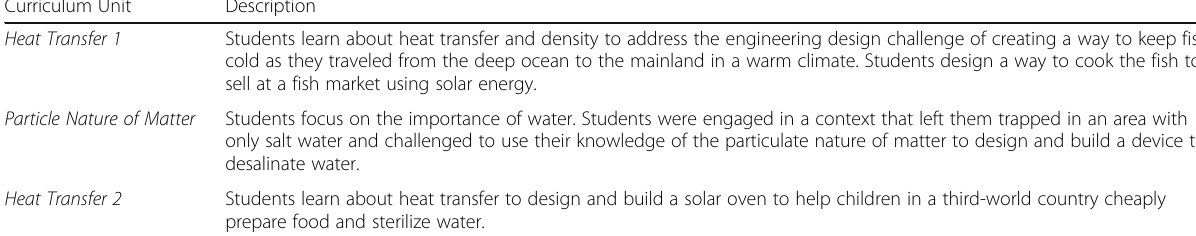
Table 2 Description of co-created integrated STEM curriculum unit Curriculum Unit Description